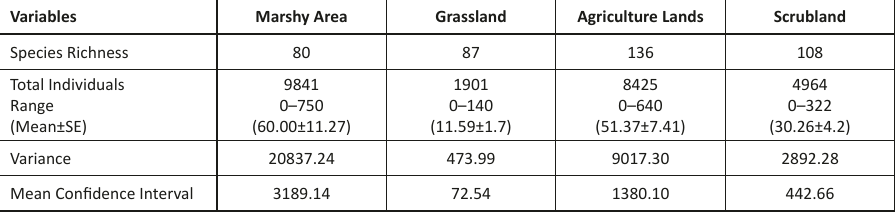
Table 2. Habitat-wise species richness and other statistical parameters of birds of Manjeera Wildlife Sanctuary, Andhra Pradesh, India